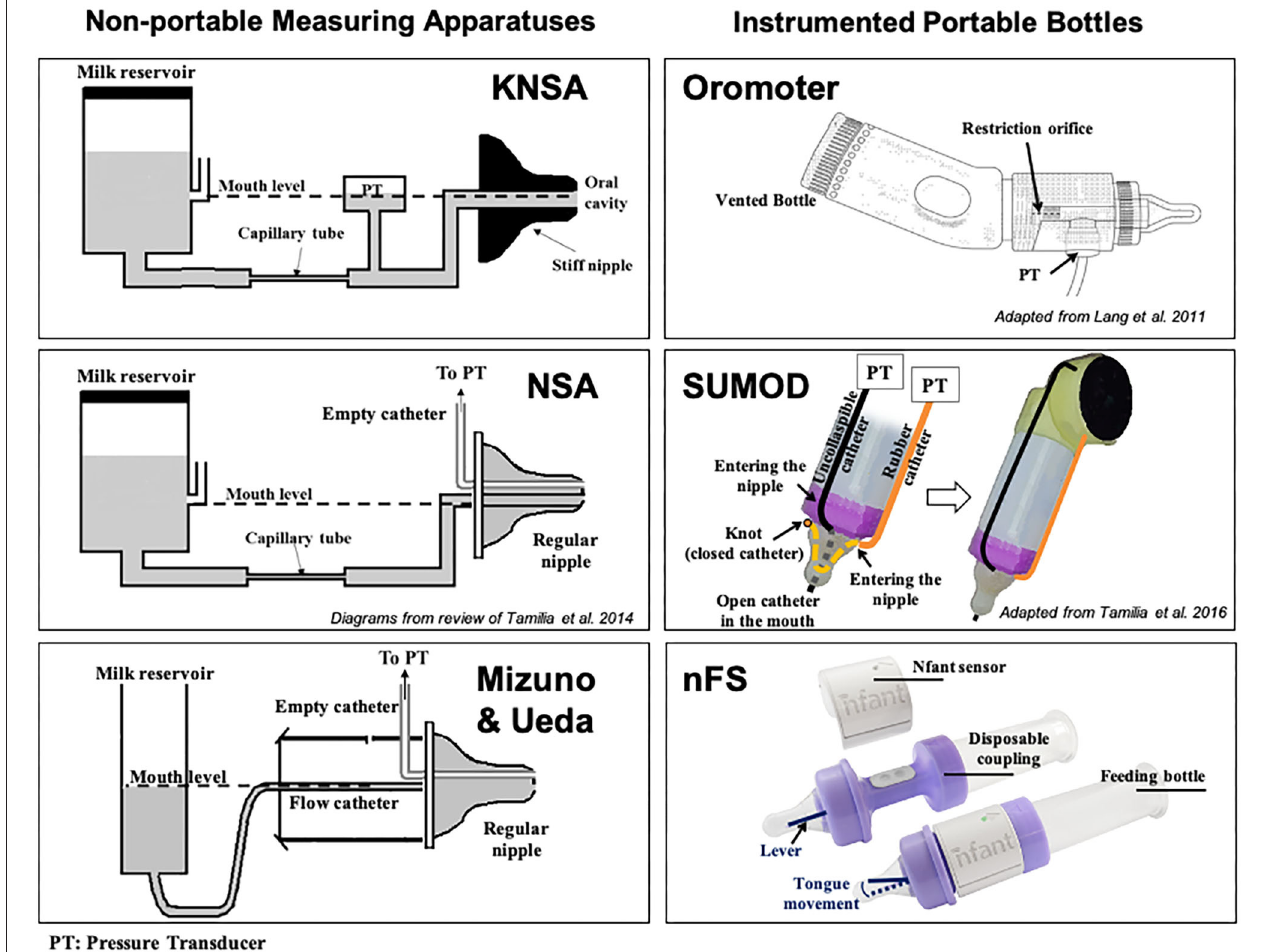
FIGURE 7 | Technological solutions to assess neonatal sucking. Schematic diagrams of some technological solutions used to measure sucking during bottle feeding in infants. (Left) Non-portable measuring apparatuses [KNSA (77), NSA (79), and Mizuno-Ueda system (80)]: pressure transducers (PTs) are used to measure sucking pressures exerted on a nipple, which is not connected to a regular feeding bottle, but to a reservoir containing milk via a flow-regulating capillary tube or regular catheter. The milk reservoir is always kept at the mouth level to eliminate net hydrostatic pressure (unlike in regular bottle-feeding sessions). Regular nipples were used in NSA and Mizuno & Ueda’s systems, while a stiff nipple was used in KNSA. (Right) Portable measuring solutions: feeding bottles instrumented with pressure transducers (PTs) to measure different sucking pressures [Orometer ( 81) and SuMOD (82): via air-filled catheters] or tongue movement (nFS; via a lever). These solutions were designed to be attached to regular bottles for easy use in clinical settings. Orometer measures the suction component of sucking; nFS measures tongue movement (related to the expression component); while SuMOD measures suction and expression components separately (enabling coordination assessment). nFS is a wireless solution, while Orometer and SuMOD require wired connection to an acquisition